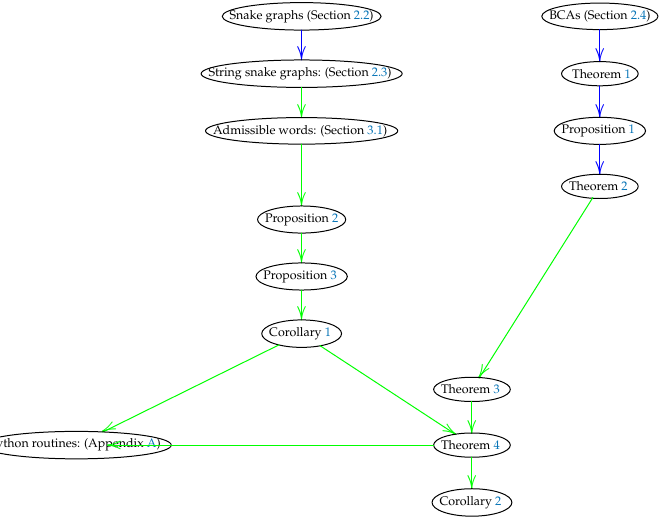
Figure 1. This graph shows how we use topics described in the Background section to obtain the main results presented in this